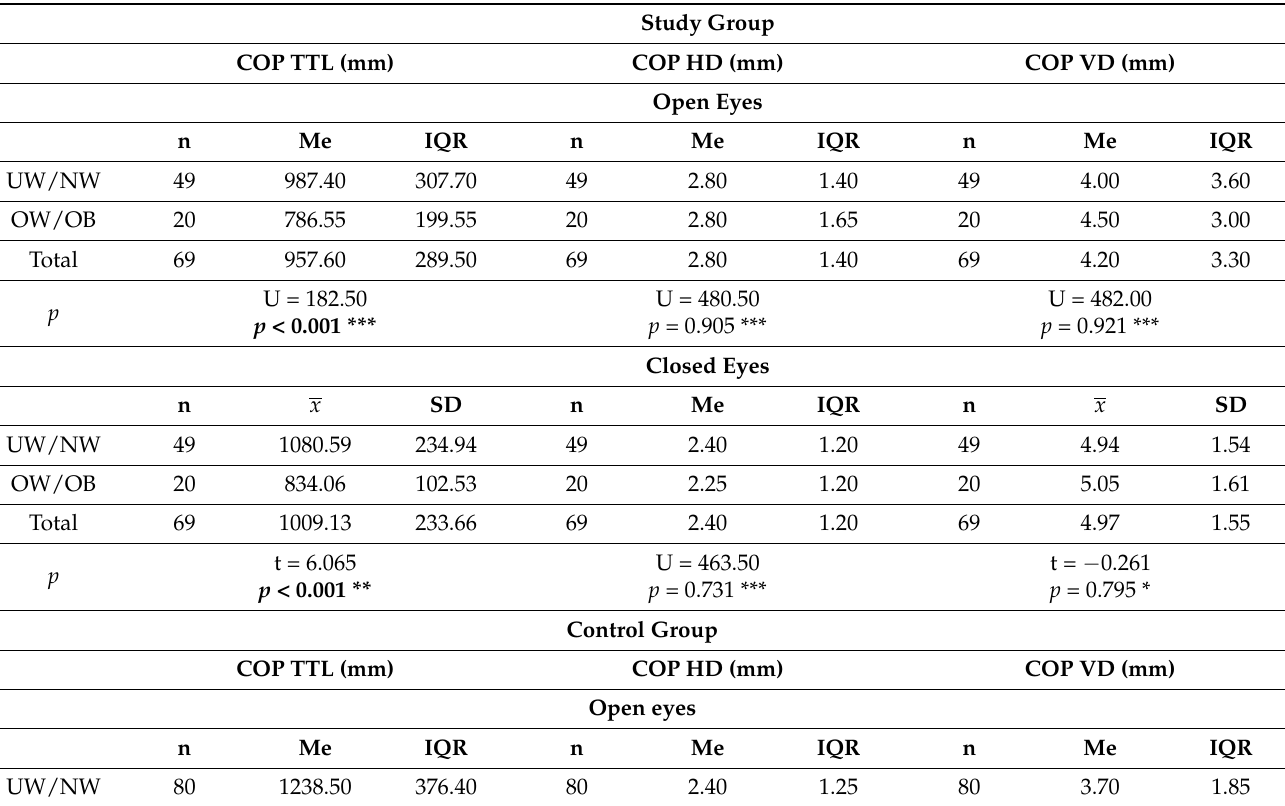
Table 4. Differences in the values of the center-of-pressure depending on the weight category. Study